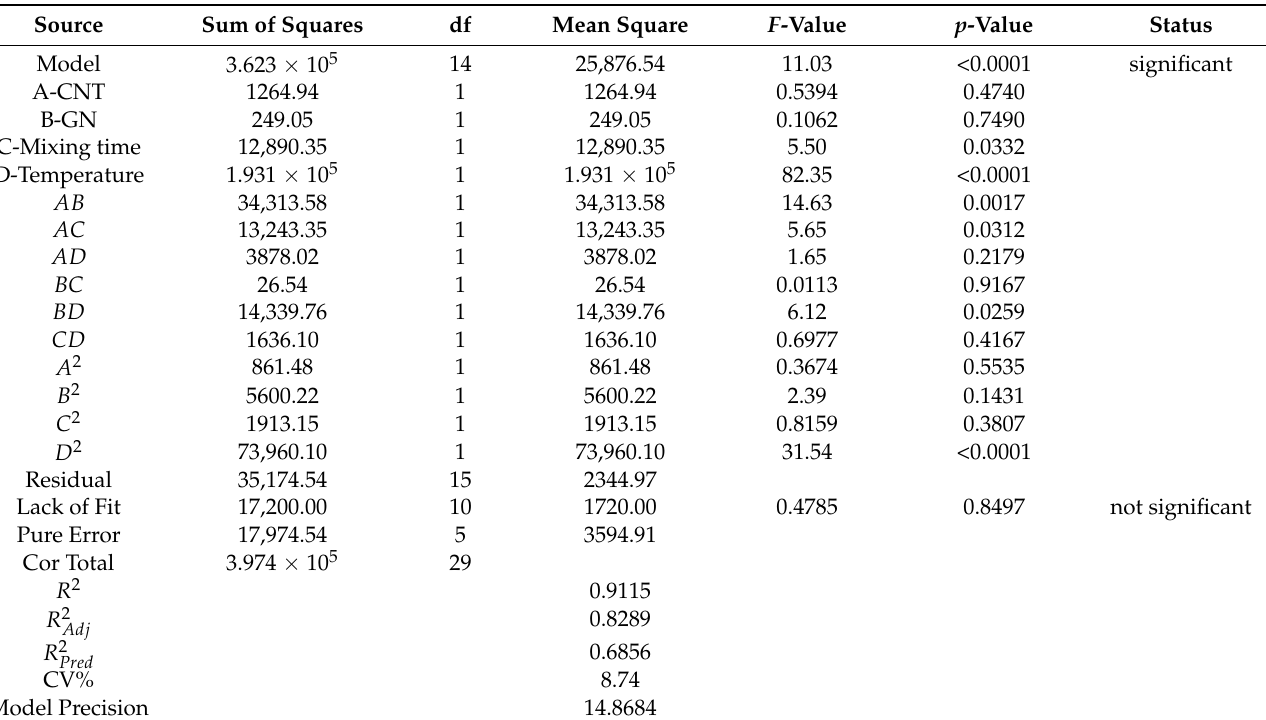
Table 4. Analyses of variance (ANOVA) for the response surface model for the compression modulus of CNT/GN-RTV composites using